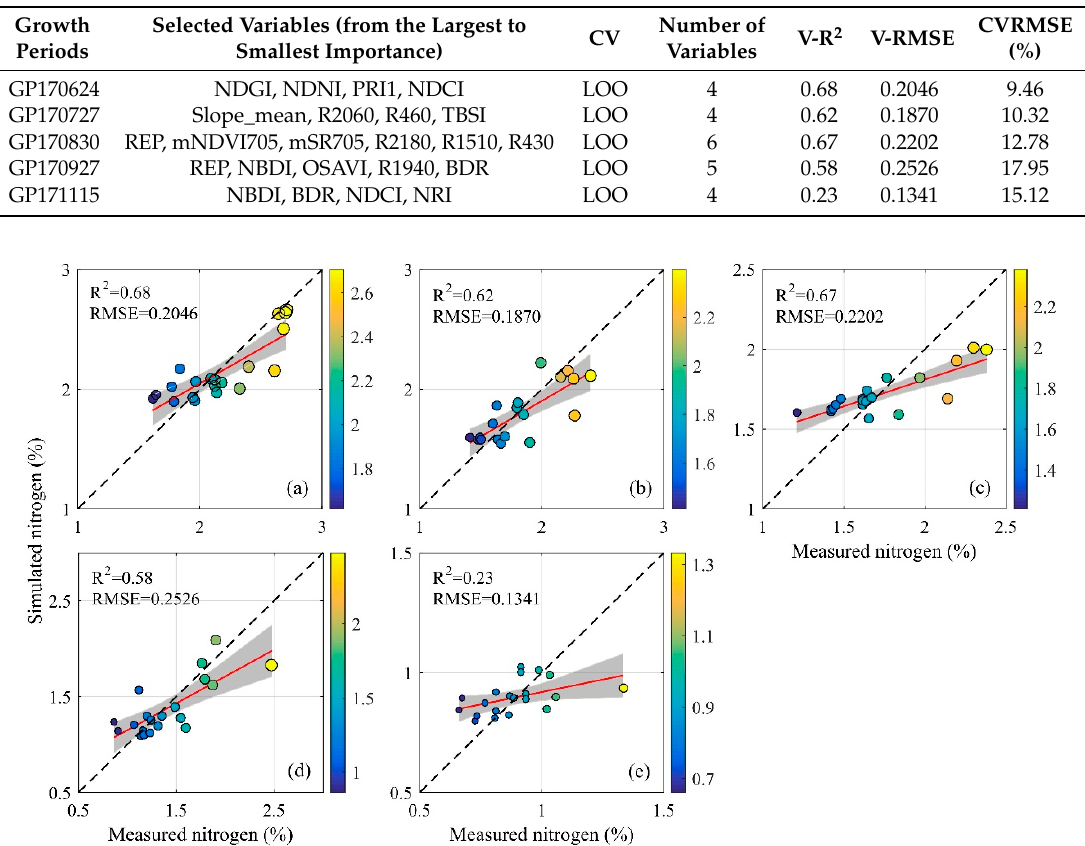
Figure 6. Relationship between the simulated N and observed N during different growth periods ( n = 20): ( a ) GP170624, ( b ) GP170727, ( c ) GP170830, ( d ) GP170927, and ( e ) GP171115. Both circle size and color refer to the observed N. The red line indicates the linear regression between the simulated and measured data, and the grey area is the 95% confidence level interval.